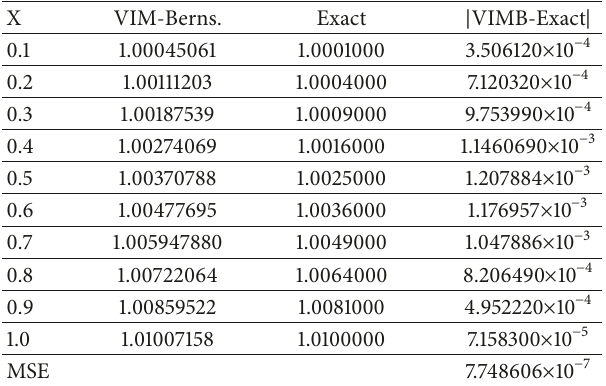
Table 5: The absolute and mean square errors using y 2 for (33) when n=m=2 and 𝑡 = 0.01 .